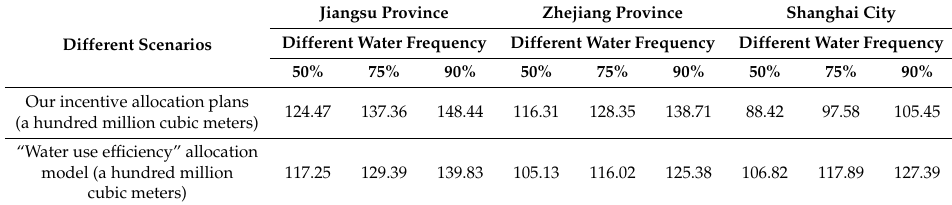
Table 4. The solutions and comparison for different allocation methods of provincial initial water rights in the Taihu Basin (under water frequencies of 50%, 75%, and 90%, planning year